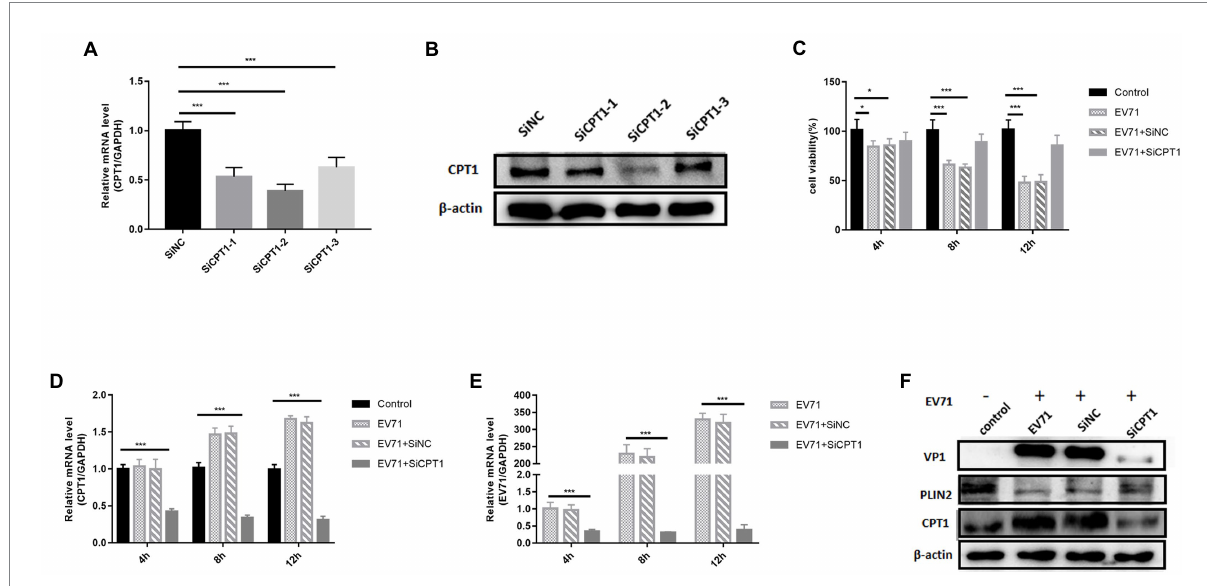
FIGURE 6 The replication of EV-A71 was inhibited after knocked down CPT1 gene. (A,B) SiCPT1 with the highest knockdown efficiency was screened. (A) The expression levels of CPT1 gene was detected by RT-qPCR. (B) The protein expression levels of CPT1 was detected. (C)–(E) 4 h, 8 h, and 12 h after virus infection. (C) The cell viability detected by CCK8. (D,E) The expression levels of CPT1 and EV-A71 gene detected by RT-qPCR. The label of control is blank, EV-A71 is be infected with EV-A71, EV-A71 + SiNC is be treated with SiNC and then be infected with EV-A71, EV-A71 + SiCPT1 is be treated with SiCPT1 and then be infected with EV-A71. (F) The expression levels of VP1, PLIN2 and CPT1 proteins were detected after virus infection for 12 h. the label of control is a blank, EV-A71 is be infected with EV-A71, SiNC is be treated with SiNC and then be infected with EV-A71, and SiCPT1 is be treated with SiCPT1 and then be infected with EV-A71. All the experiments were carried out in triplicate. Error bars represent SEM. * means p < 0.05, ** means p < 0.01, *** means p <